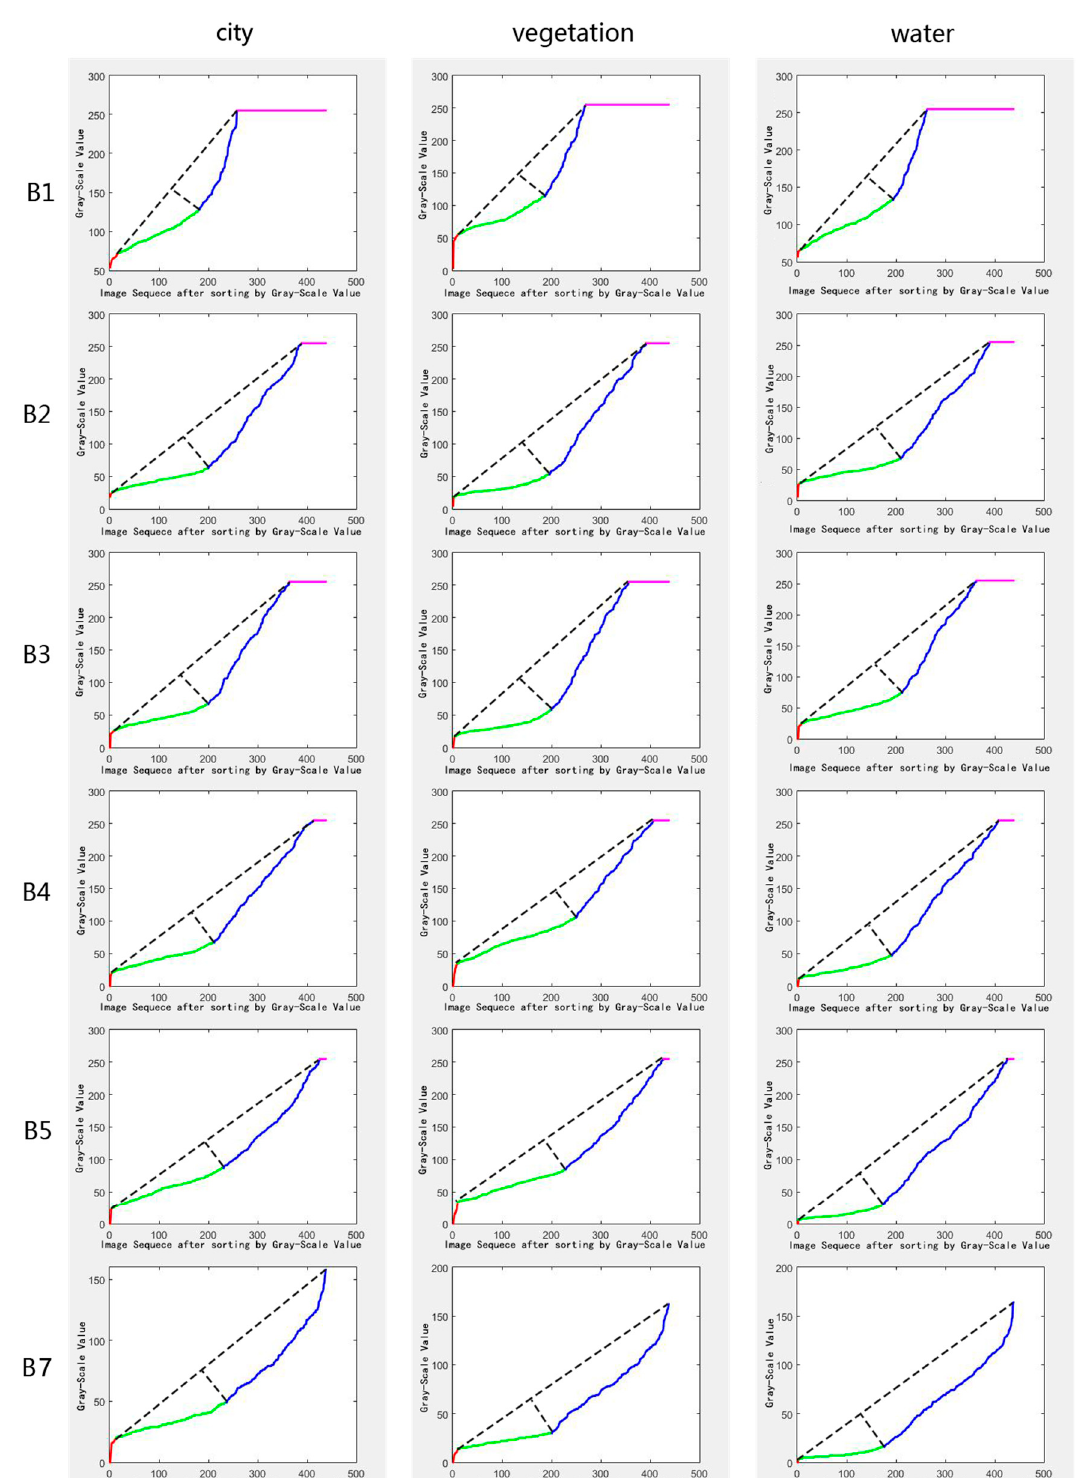
Figure 4. Schematic diagram for the variations of the time-series’ gray-scale value curves in multiple bands for three different land surface types (city, vegetation, and water body). The normal observation (indicated by green line) and abnormal observation values (indicated by red, blue and pink line) have obvious points of inflection at the visible ( B1–B3 ) and near-infrared bands ( B4 ), however this feature is not obvious for the two short-wave infrared bands ( B5 and B7 ). The dashed lines connect the smallest gray-scale values, clear pixels and largest cloudy pixels, and the inflection points can be determined by searching the maximum distances from the arcs to the dashed